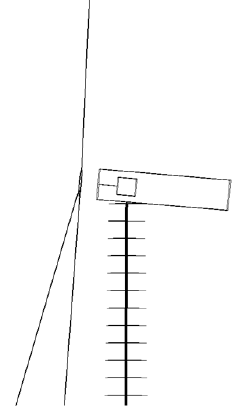
Figure 4. Schematic diagram of the floating wind turbine with TMD.